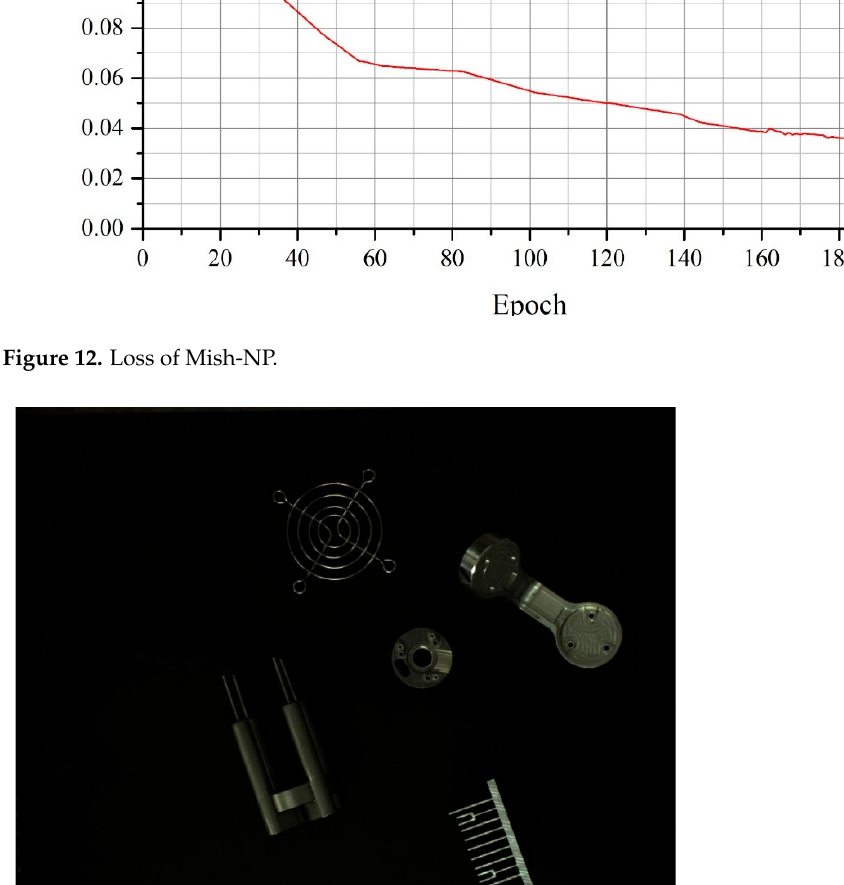
Figure 14. Results of Traditional YOLOv5. (a) SiLU (b)Mish Figure 15. Results of NP-YOLOv5.